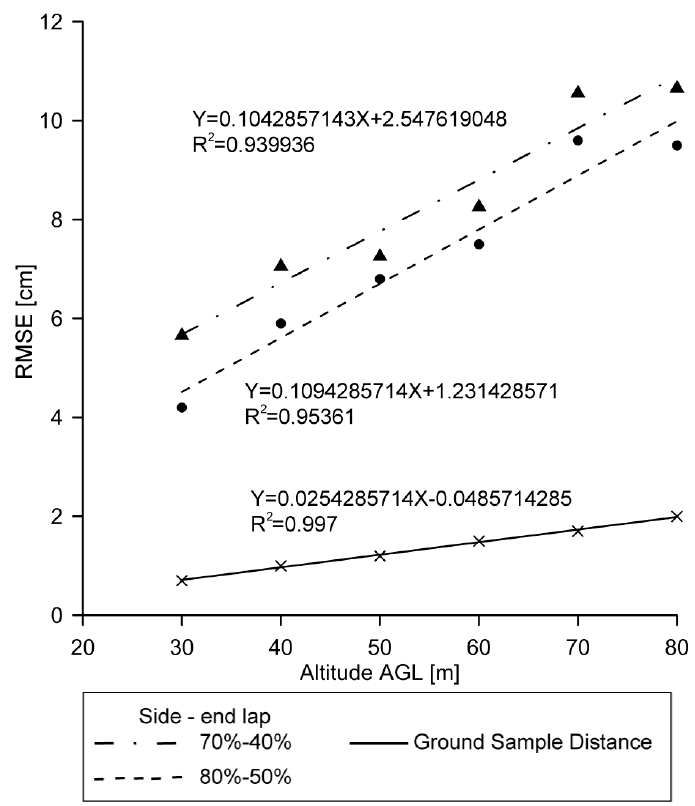
Figure 9. Linear model analyzing forward and side lap settings against altitude AGL and RMSE.